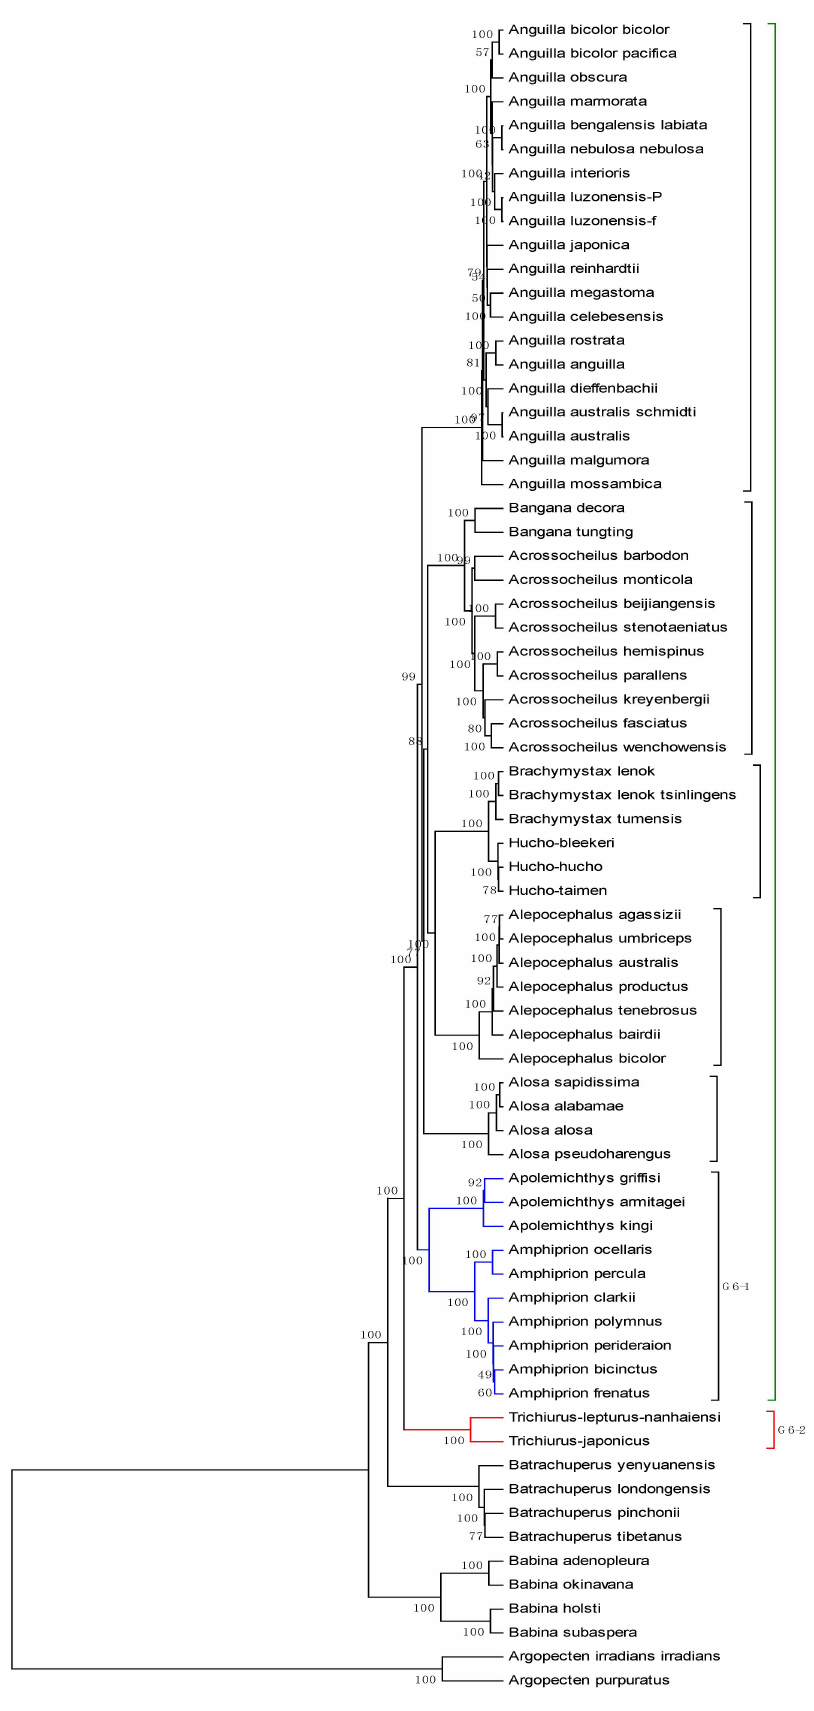
Figure 7. The tree of 70 genome sequences constructed with multiple